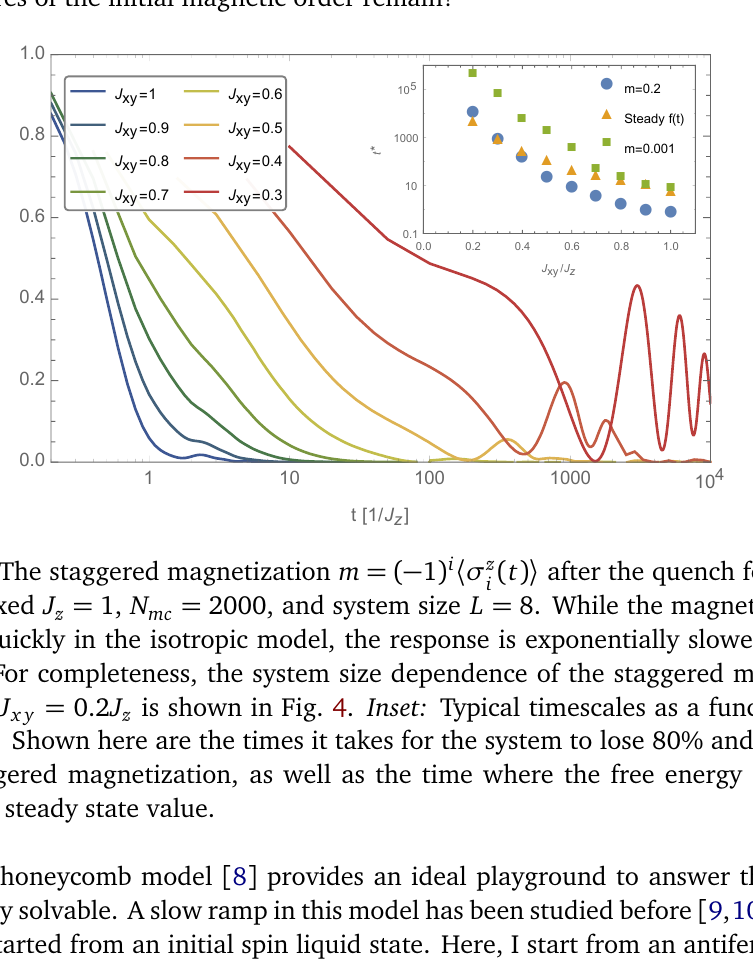
Figure 1: The staggered magnetization m = ( − 1 ) i 〈 σ z = 1, N = 2000, and system size L = 8. While the ous J , fixed J x y z mc